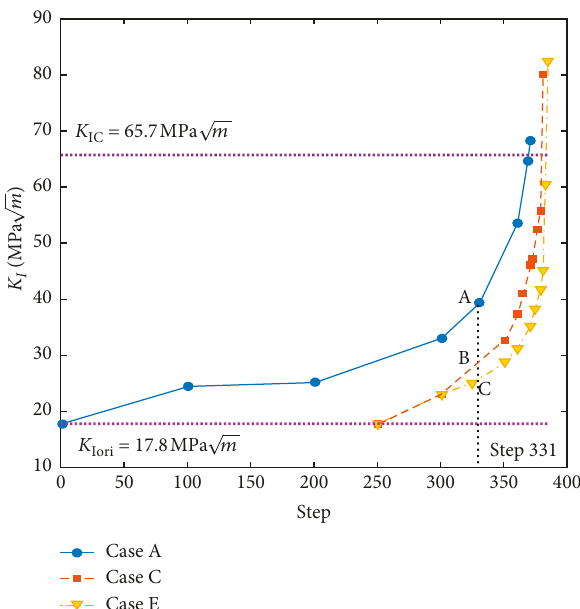
Figure 26: Time-varying curves of the stress intensity factor K I of steel wires corresponding to the cases in Figure 25. The original data of